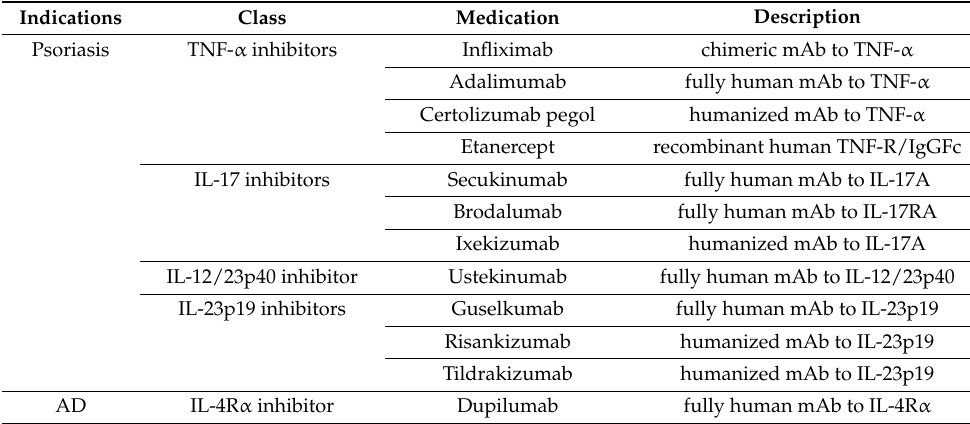
Table 1. Biologic agents used to treat psoriasis and